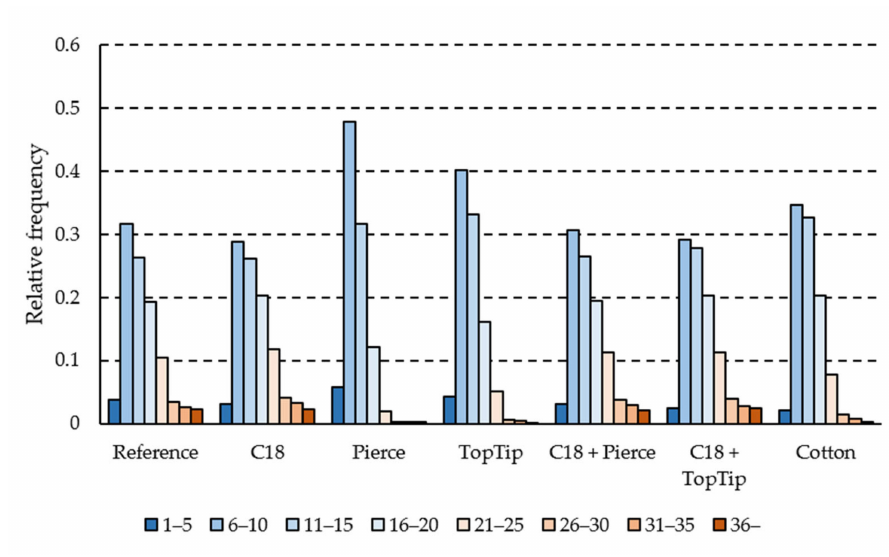
Figure 3. Peptide length distributions of detected peptides for the SPE cleanup methods.